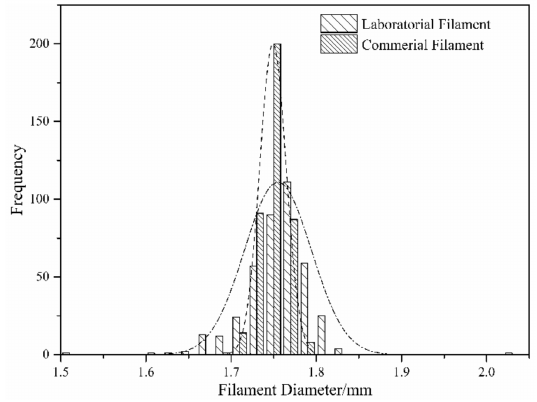
Figure 4. Diameter distribution: the laboratorial filament and commercial